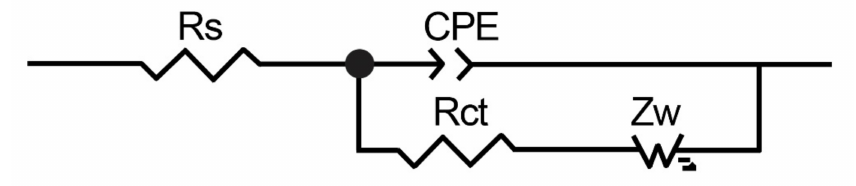
Figure 8. Equivalent circuit for fitting the impedance